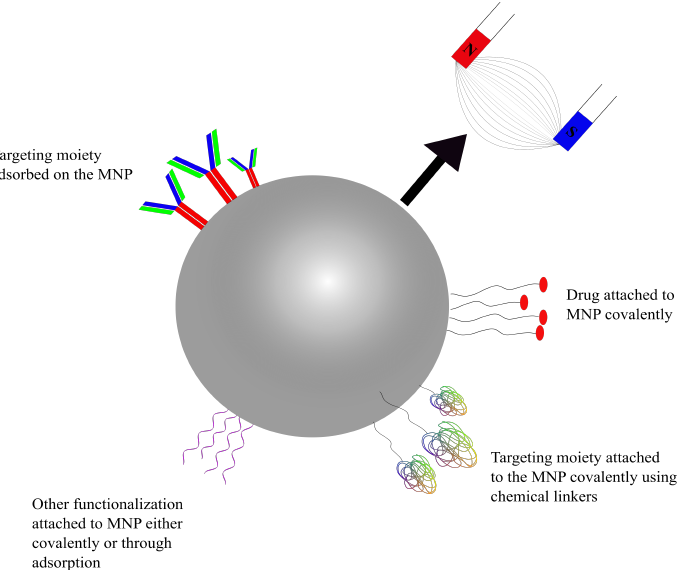
Figure 5. A schematic representation of a functionalized, drug-carrying magnetic NP. Targeting moieties and drugs can either be adsorbed or covalently attached using